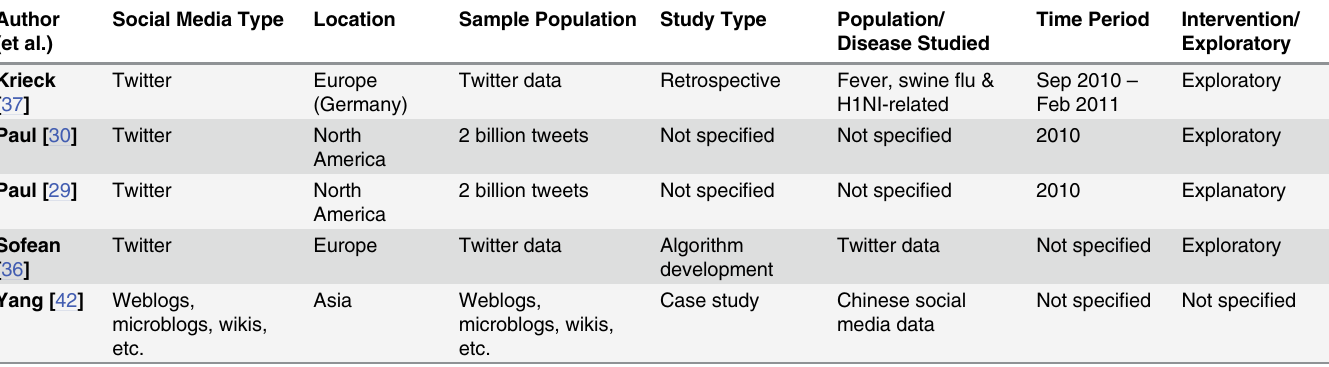
Table 7. Characteristics of 5 “ other ” topic studies addressing research question 1 a . Author (et